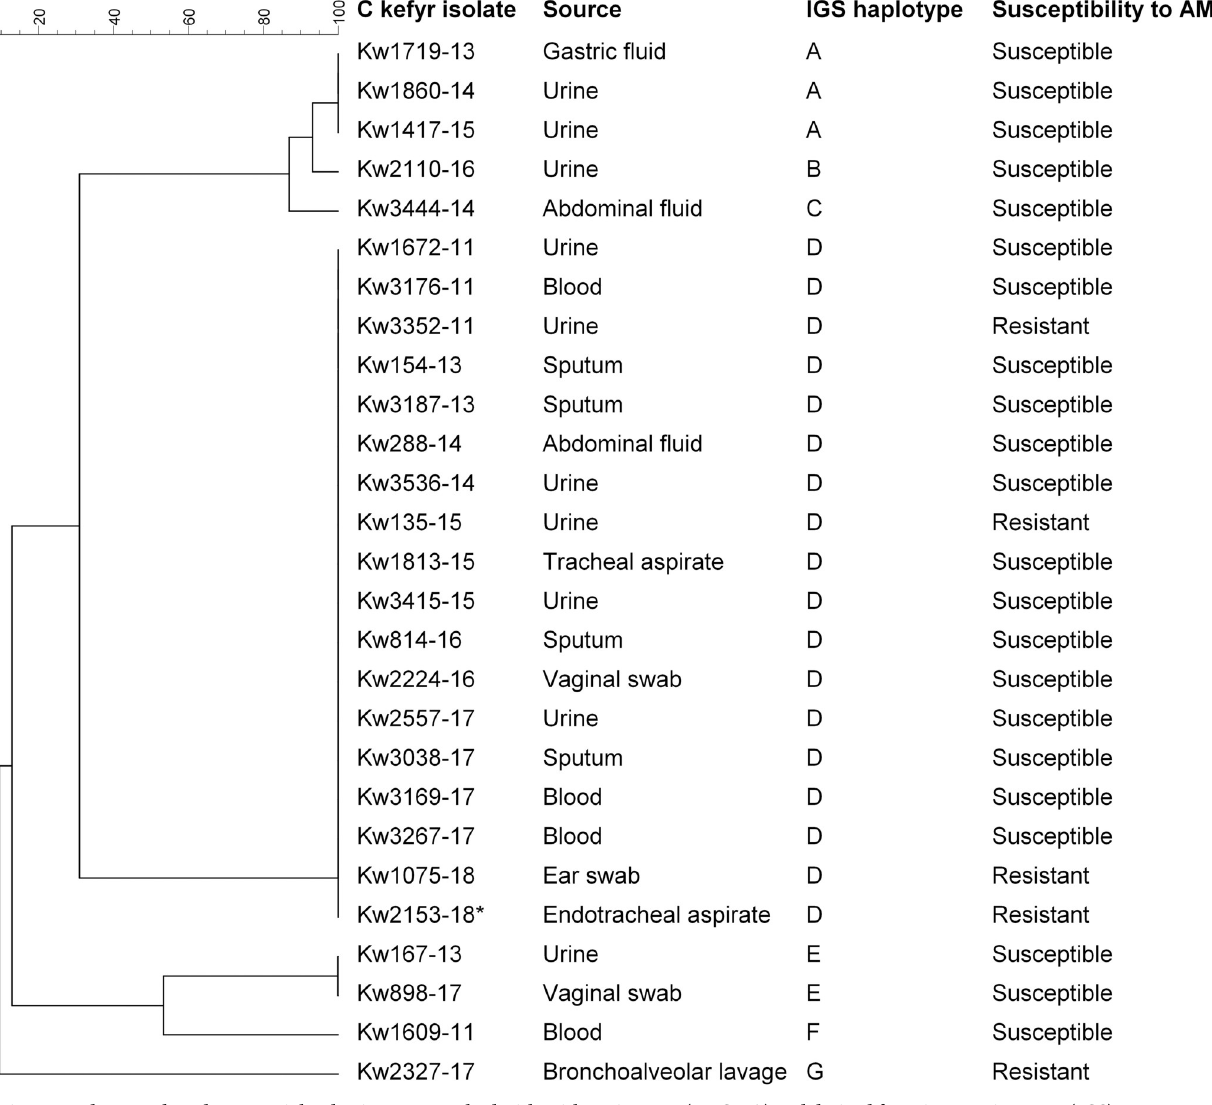
Fig 1. Dendrogram based on unweighted pair group method with arithmetic mean (UPGMA) and derived from intergenic spacer (IGS)-1 sequence data for 27 C . kefyr isolates. The source of isolation and susceptibility to amphotericin B (AMB) are also shown for each isolate.